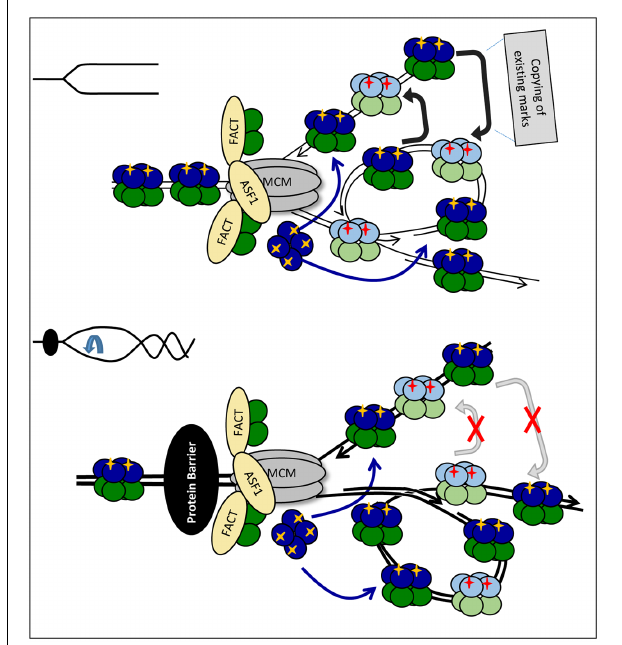
FIGURE 4 | Fork rotation and loss of communication between leading and lagging strands. Upon approaching the impediment (a non-histone DNA-binding protein is shown by a black oval) H3/H4 histones are transferred and deposited onto the new strands as tetramers, but the fork is distorted by rotation and catenation (bottom). If some PTMs on the new histones are copied from the corresponding nucleosome on the sister DNA strand, the distortion of the fork will prevent the transmission of these marks. This loss of marks will come on top of the loss of marks due to the reduced availability of “old” H3/H4 as depicted in Figure 3A